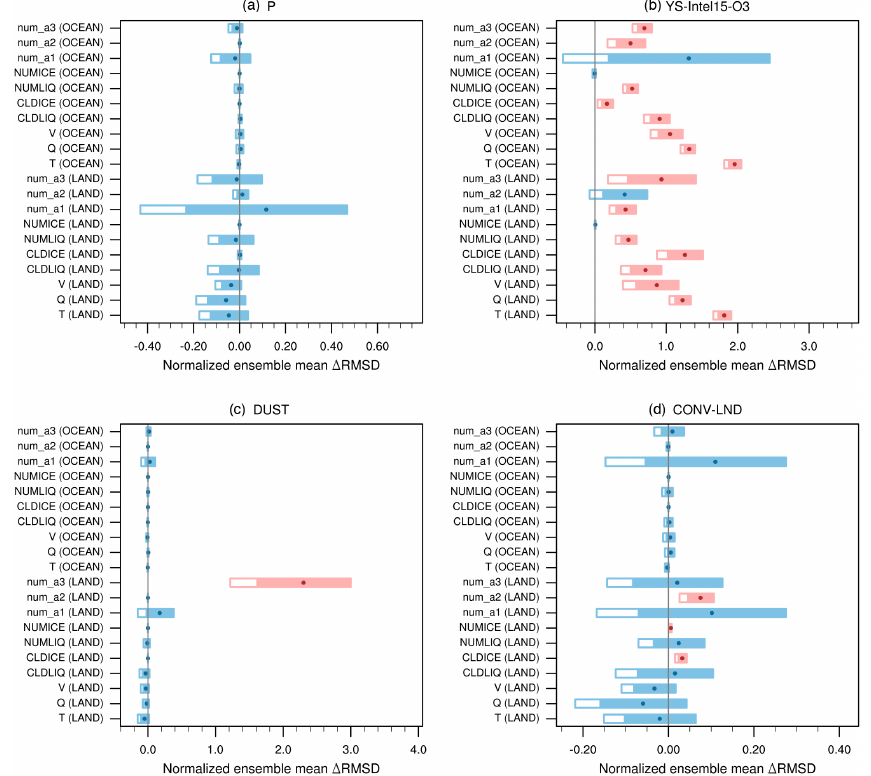
Figure 5. Ensemble-mean (cid:49) RMSD t,j (dots) and the ± 2 σ range of the mean (filled boxes) where σ denotes the standard deviation. The left end of an unfilled box shows the threshold value corresponding to P 0 = 0 . 5% in the one-sided t test. All values shown here have been normalized by the mean RMSD of the trusted ensemble, i.e., RMSD trusted ,t,j , of the corresponding prognostic variable and domain (see y axis labels). Red and blue indicate fail and pass, respectively, according to the criterion defined by Eq. (6). Results are shown at t = 5min for four test cases: (a) P , (b) YS-Intel15-O3, (c) DUST, and (d) CONV-LND. The test case configurations are explained in Table 1 and Sect.